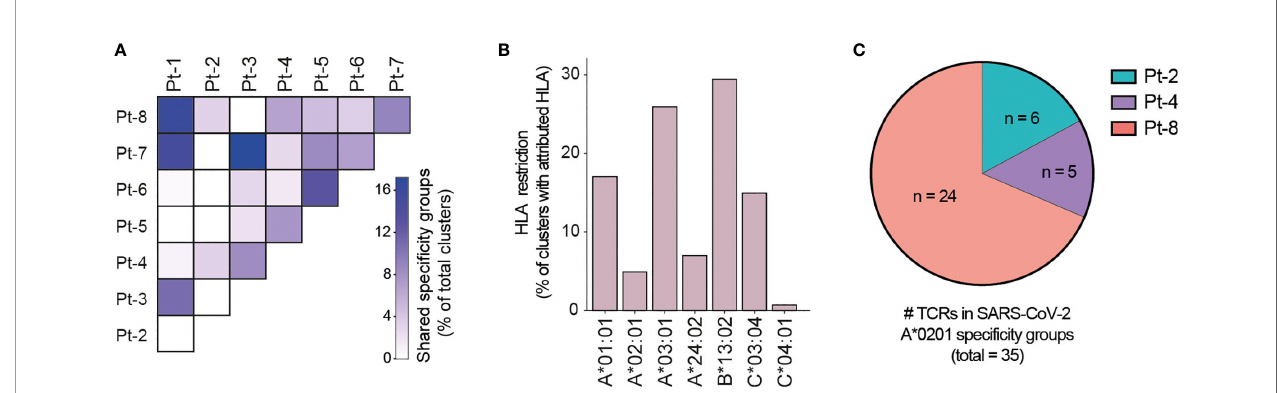
FIGURE 6 | GLIPH2 analysis of single-cell paired TCR repertoires reveals candidate SARS-CoV-2-speci fi c TCRs. (A) Heatmap shows the proportion of TCR speci fi city groups containing sequences from speci fi c pairs of patients, as determined by GLIPH2 analysis (total TCR clusters = 552). (B) Bar plot displays the proportions of predicted HLA class I alleles in HLA-attributed TCR speci fi city groups (total TCR clusters = 552). (C) Graph displays the proportions and numbers of candidate SARS-CoV-2-speci fi c TCRs derived from HLA-A*0201-positive patients, as determined by GLIPH2 clustering with known SARS-CoV-2-speci fi c TCR